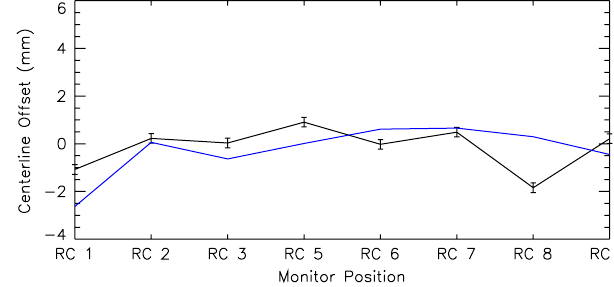
FIG. 14. (Color) A comparison of the predicted and measured ring steering trajectories. The black line is the previous magnetic field compensation value, while the light blue line is the one calculated in this study. The dark blue line is the predicted trajectory for the previous compensation value, while the red line is the predicted trajectory for the settings determined in this